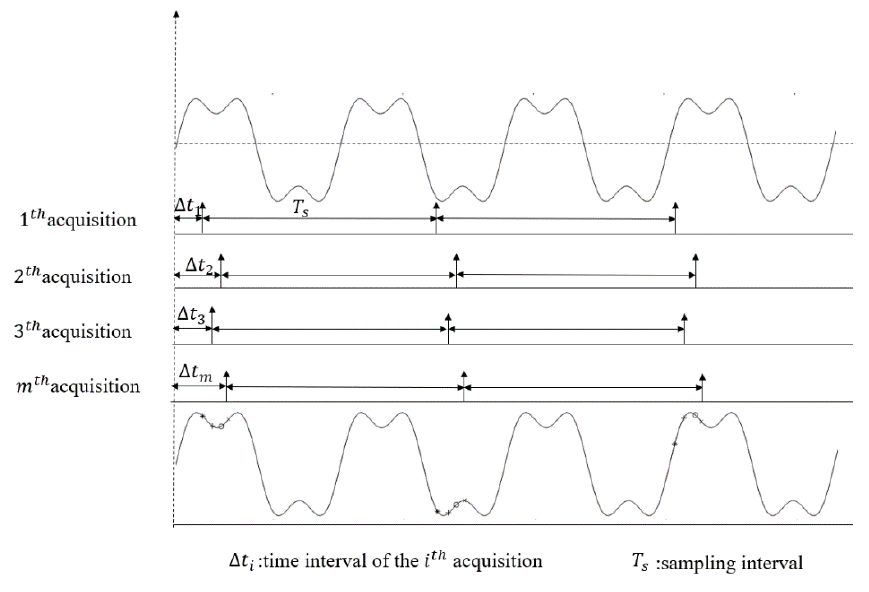
Figure 1. Schematic Diagram of random equivalent sampling (RES).